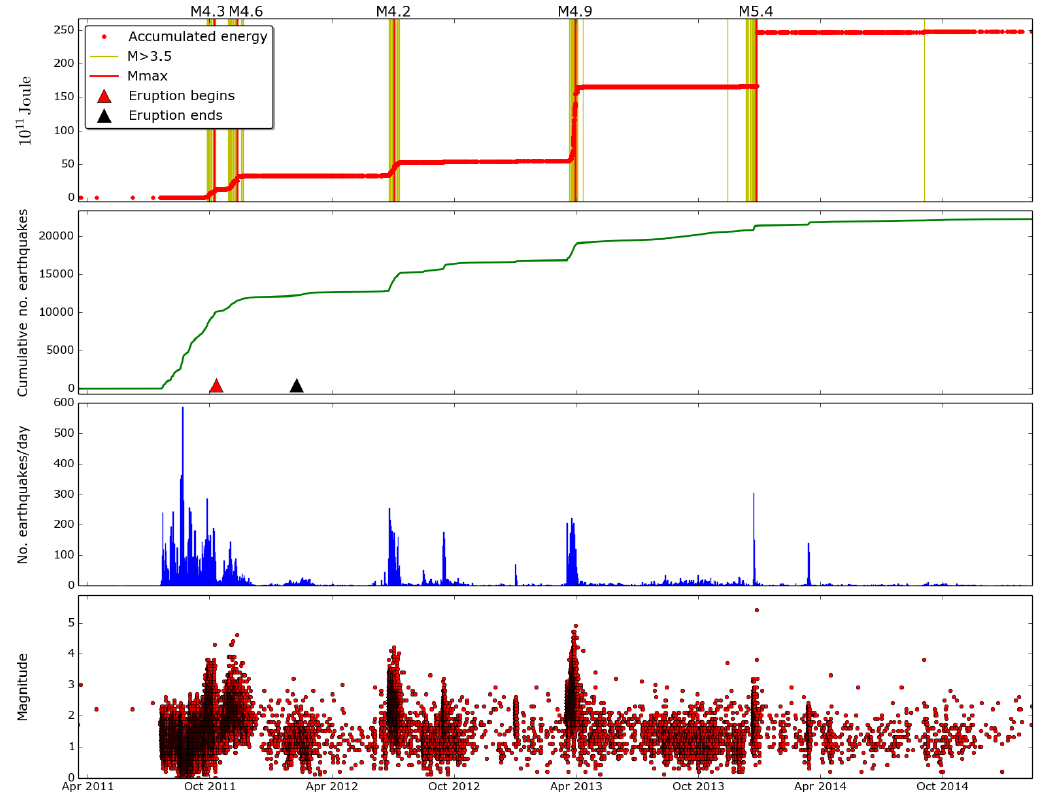
Figure 2. Evolution of the seismic activity at El Hierro island between 18 March 2011 and 12 February 2015. Data are from the IGN public earthquake catalogue and the IGEO-CSIC seismic research